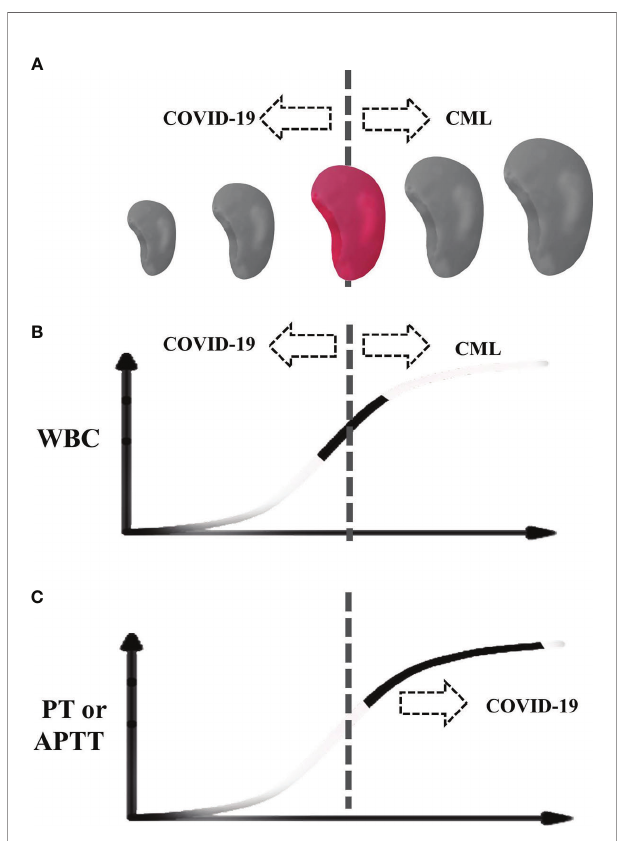
FIGURE 3 | Schematic diagram of our case during COVID-19. (A) The spleen size. (B) White blood cell. (C) Prothrombin time and activated partial thromboplastin time. The dotted line indicates the center of normal size or normal range. Colored spleen and solid curve indicate the range of the